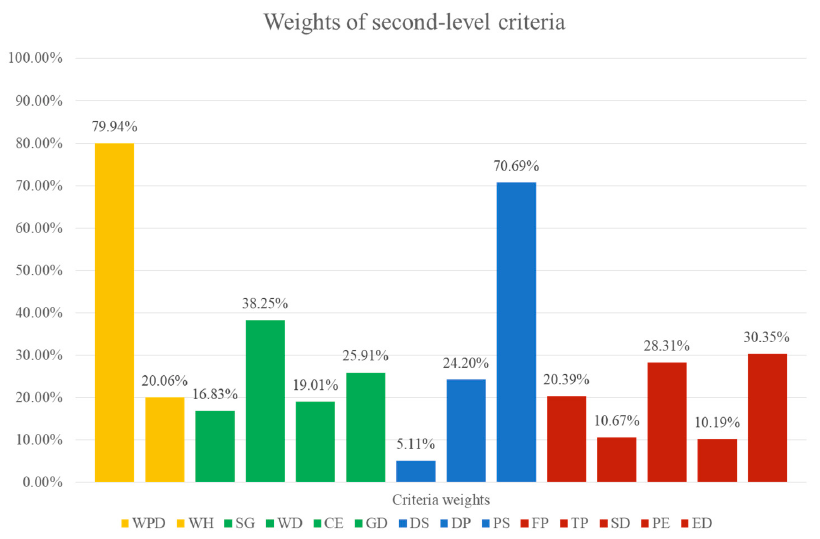
Figure 7. Weights of second-level criteria.